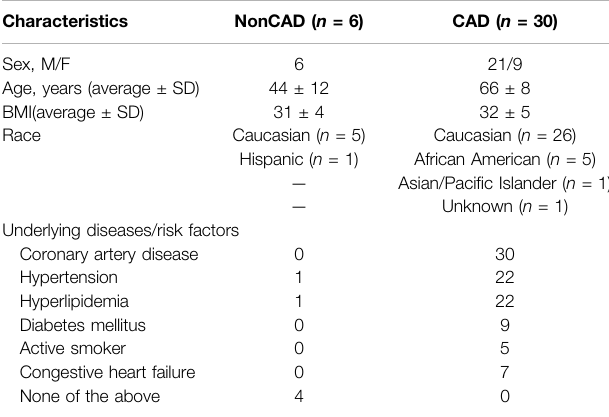
TABLE 1| PatientDemographics. CAD,coronary artery disease; BMI, bodymass index; M, male; F, female. n indicates number of patients.